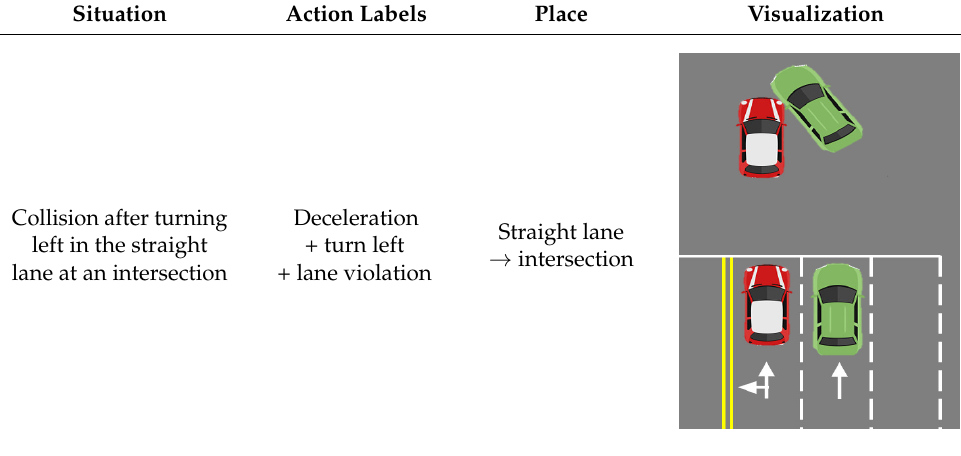
Table 5. Example of vehicle accident analysis; the green vehicle perspective is on the right.